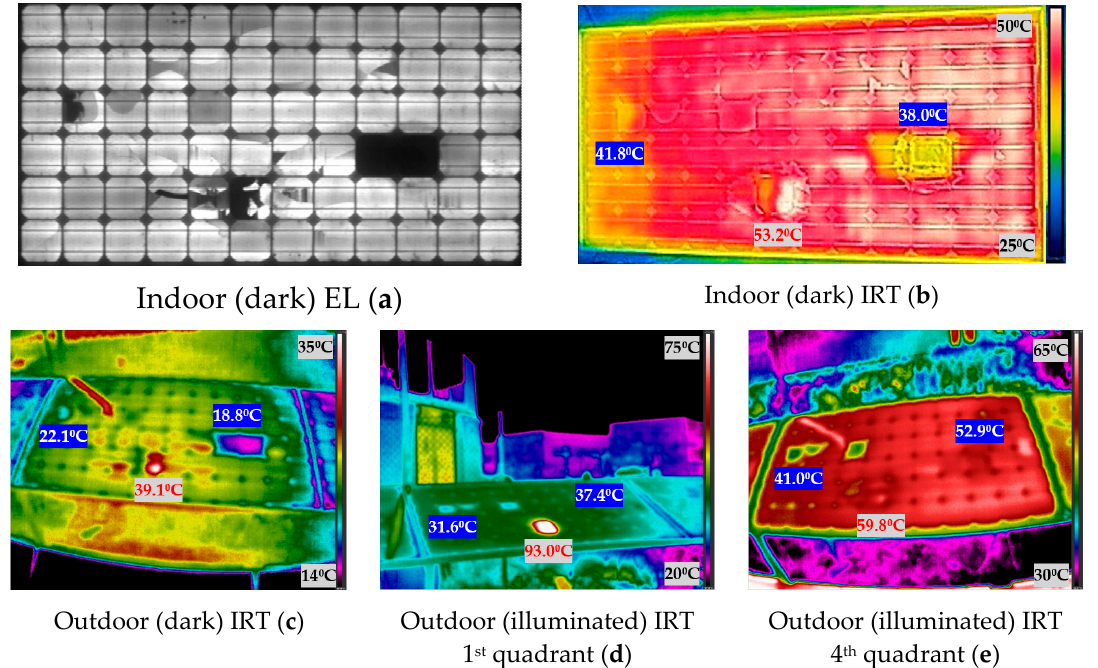
Figure 9. Indoor and outdoor characterization images of module 1: ( a ) indoor (dark) electroluminescence (EL); ( b ) indoor (dark) infrared thermography (IRT); ( c ) outdoor (dark) IRT; ( d ) outdoor (illuminated) IRT first quadrant; ( e ) outdoor (illuminated) IRT fourth quadrant.